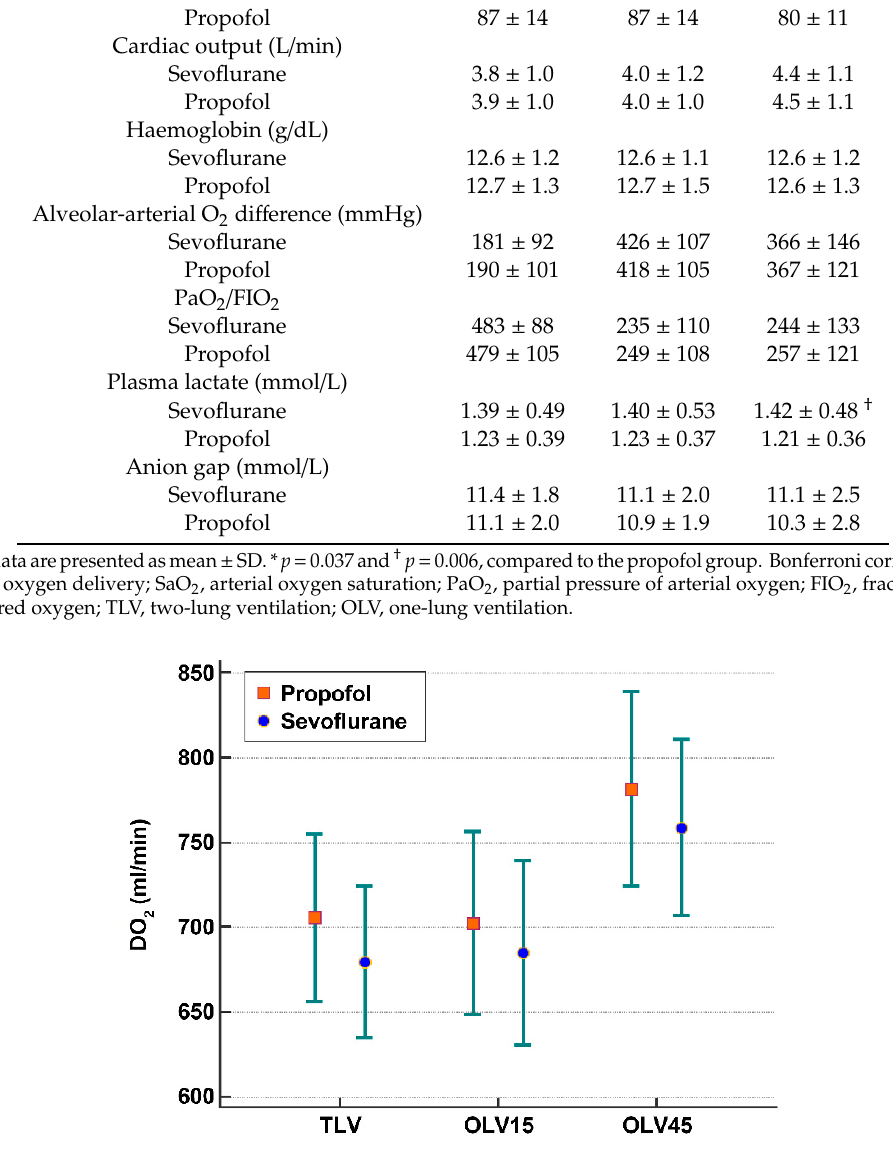
Figure 2. DO 2 between sevoflurane and propofol in each time point. There was no di ff erence in DO 2 between the propofol and sevoflurane groups. DO 2 increased with time. p = 0.0001 between TLV and OLV45, p = 0.0001 between OLV15 and OLV45, Bonferroni correction. TLV, two lung ventilation; OLV15, 15 min after initiation of one-lung ventilation; OLV45, 45 min after initiation of one-lung ventilation. Stroke volume was higher in the propofol group (TLV: 54 vs. 60 mL, p = 0.037; OLV15: 61 vs. 63 mL, p = 0.507; OLV45: 62 vs. 70 mL, p = 0.072, for sevoflurane vs. propofol, respectively, Bonferroni correction). Heart rate and cardiac output (TLV: 3.8 vs. 3.9 L min ; OLV15: 4.0 vs. 4.0 L min ; OLV45: 4.4 vs. 4.5 L min , for sevoflurane vs. propofol, respectively) were not di ff erent between the two groups (Table